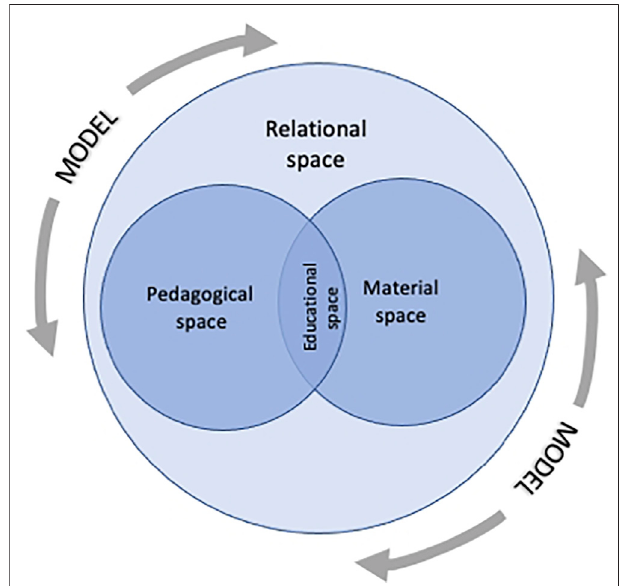
FIGURE 1 | Virtual teams